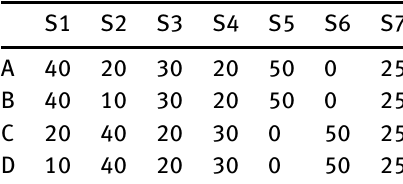
Table 1: The coupons immersed in composition of: pig dung, poultry dung, rice straw and urea solution contained in beakers for a period of 12 days with 3 days